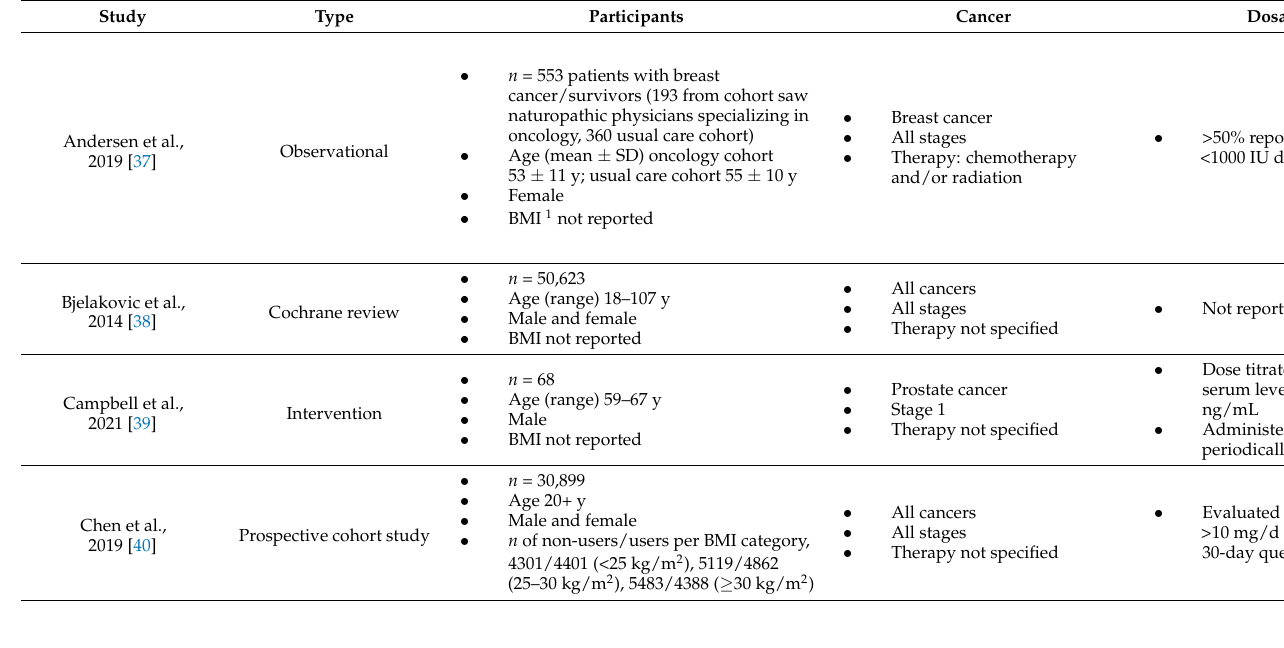
Table 1. Safety of vitamin D supplements for patients with